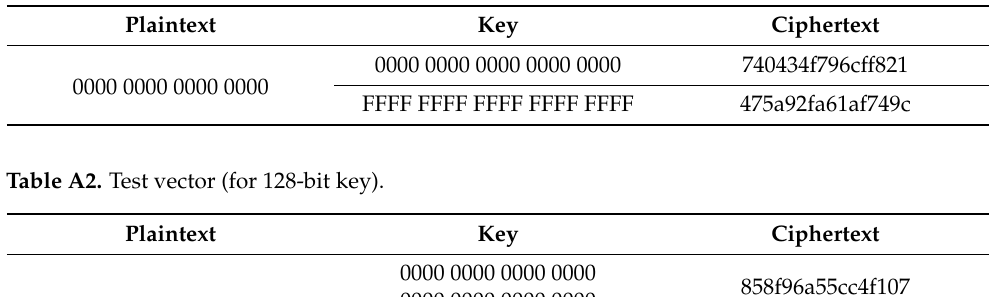
Table A1. Test Vector (for 80-bit key).